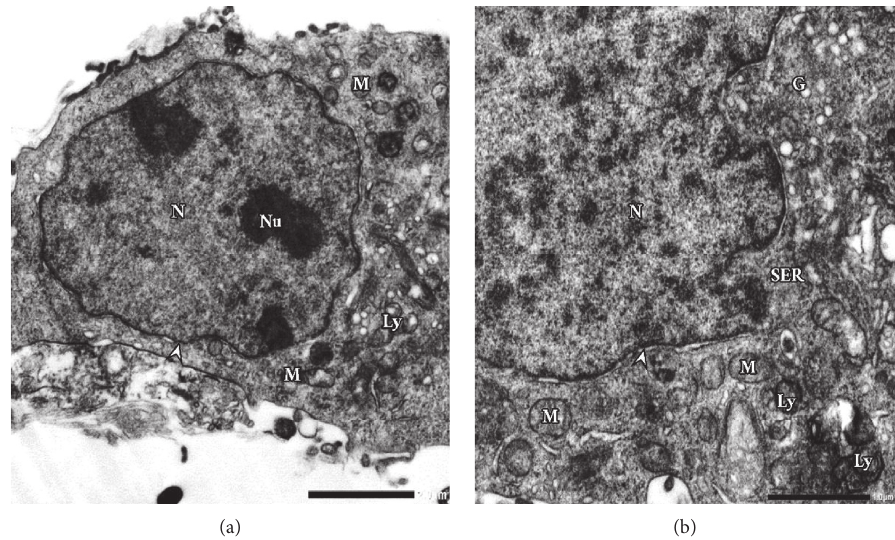
Figure 5: (a) Electron micrograph illustrates the section of untreated WMP-Y.1 cells with regular nuclear membrane (head arrow). Smooth endoplasmic reticulum (SER), golgi bodies (G), and mitochondria (M) with light dense cristae. Highly distributed lysosomes (Ly). Moreover, significant double nuclei (Nu) were observed (F 4 G 1 -OsO 4 fixed-uranyl acetate lead citrate stained preparation, 4000x). (b) High magnification showing normal distribution of chromatin and normal distribution of spherical mitochondrial organelle around the nucleus. Highly and distribution of golgi bodies and some vacuoles (8000x).